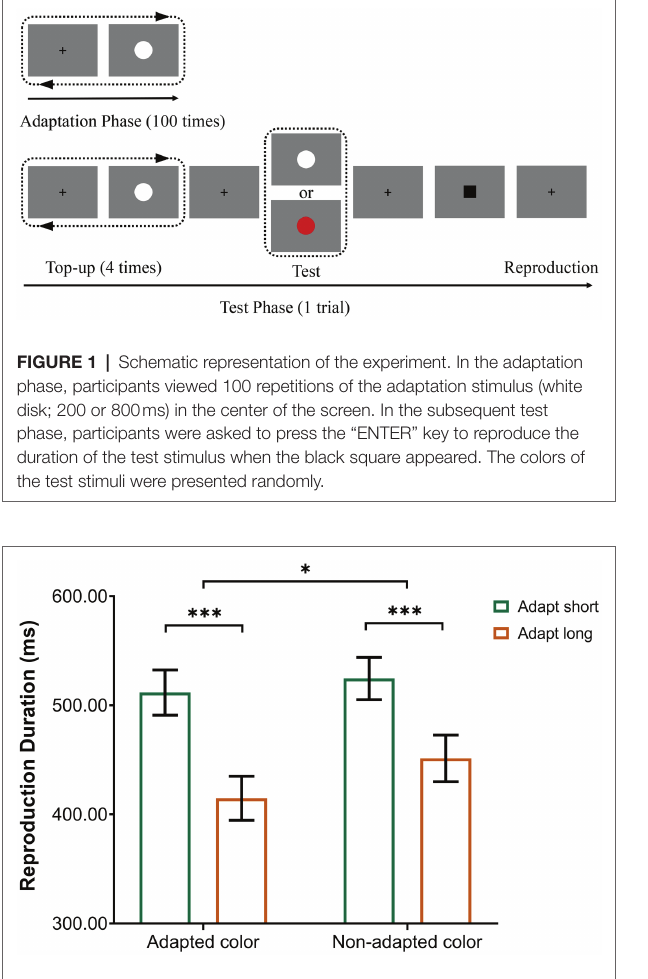
FIGURE 2 | Interaction between the conditions of Experiment 1. Error bars represent standard errors. * p < 0.05, *** p <